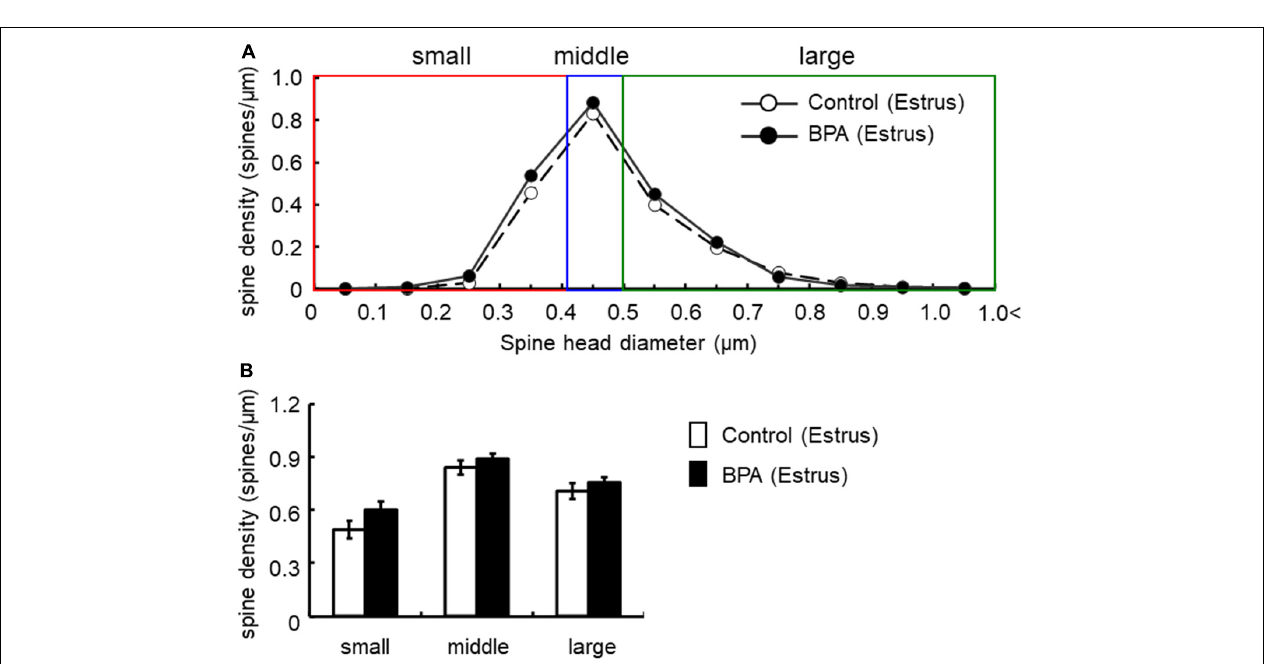
FIGURE 5 | Changes in the density of spines in the hippocampus of grownup female rats at estrus stage by perinatal BPA exposure. (A) Histogram of spine-head diameters without BPA (control, open circle) or with BPA (BPA, filled circle) in female rats at estrus stage, respectively. (B) Density of three subtypes of spines, from left to right: small-, middle-, large-head spines. Results are represented as mean ± SEM. In each group, the white and black columns are expressed for the control and BPA-treated data, respectively. We investigated 3 rats, 8 slices, 16 neurons, 31 dendrites, ∼ 3200 spines for female estrus control and 6 rats, 15 slices, 30 neurons, 60 dendrites, ∼ 6800 spines for female estrus BPA. The significance of the BPA effects was confirmed via statistical analysis using t -tests.